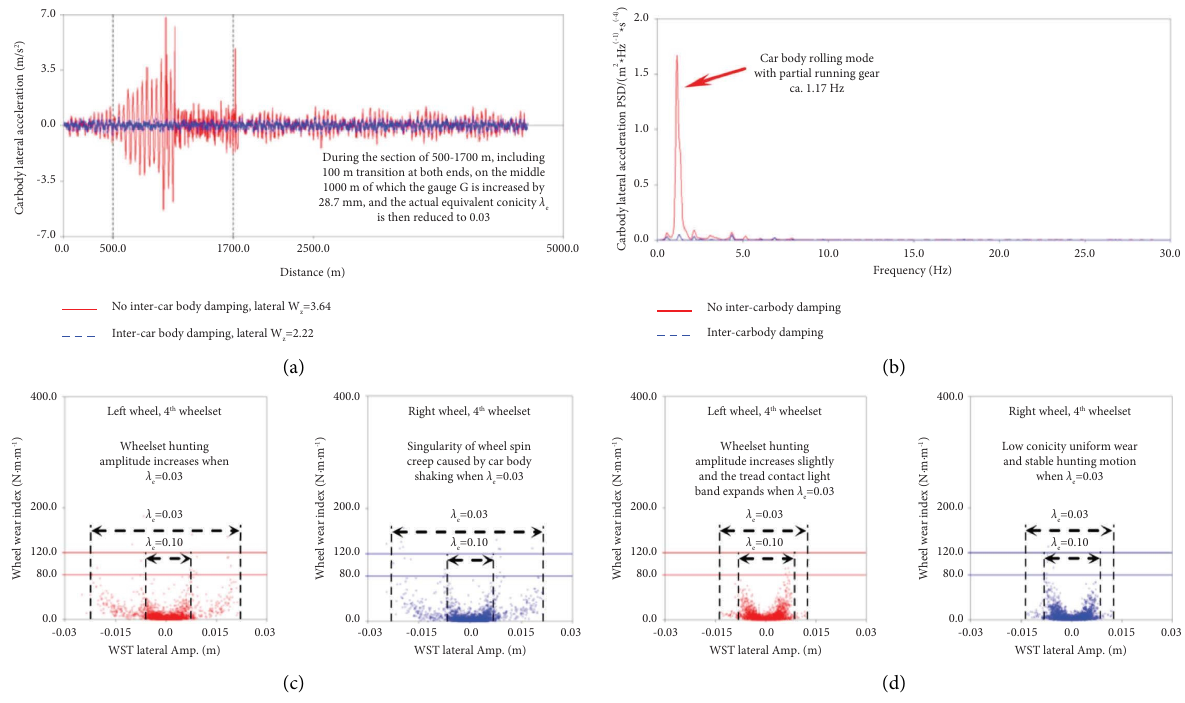
Figure 5: Efective assessments of the semiactive damping technique at MC03 under variable gauge conditions. (a) Lateral acceleration contrast at the rear-right point on the car body foor. (b) Lateral acceleration PSD contrast at the rear-right point on the car body foor. (c) Distribution contrast of wheel wear index characteristics when intervehicle damping of. (d) Distribution contrast of wheel wear index characteristics when intervehicle damping is on.